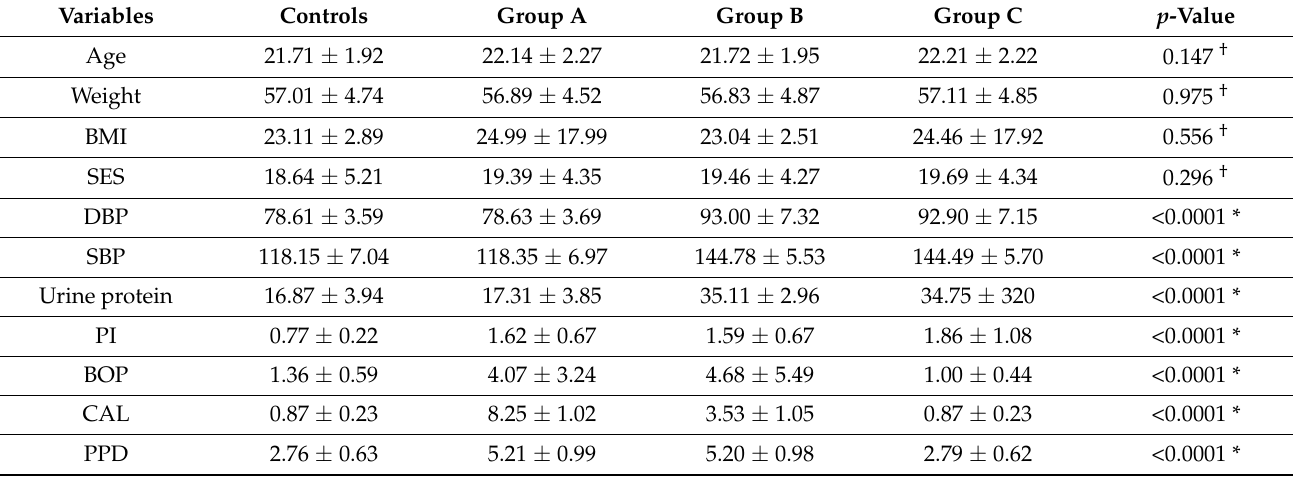
Table 4. Intergroup Comparison of demographic and periodontal variables in between the groups.